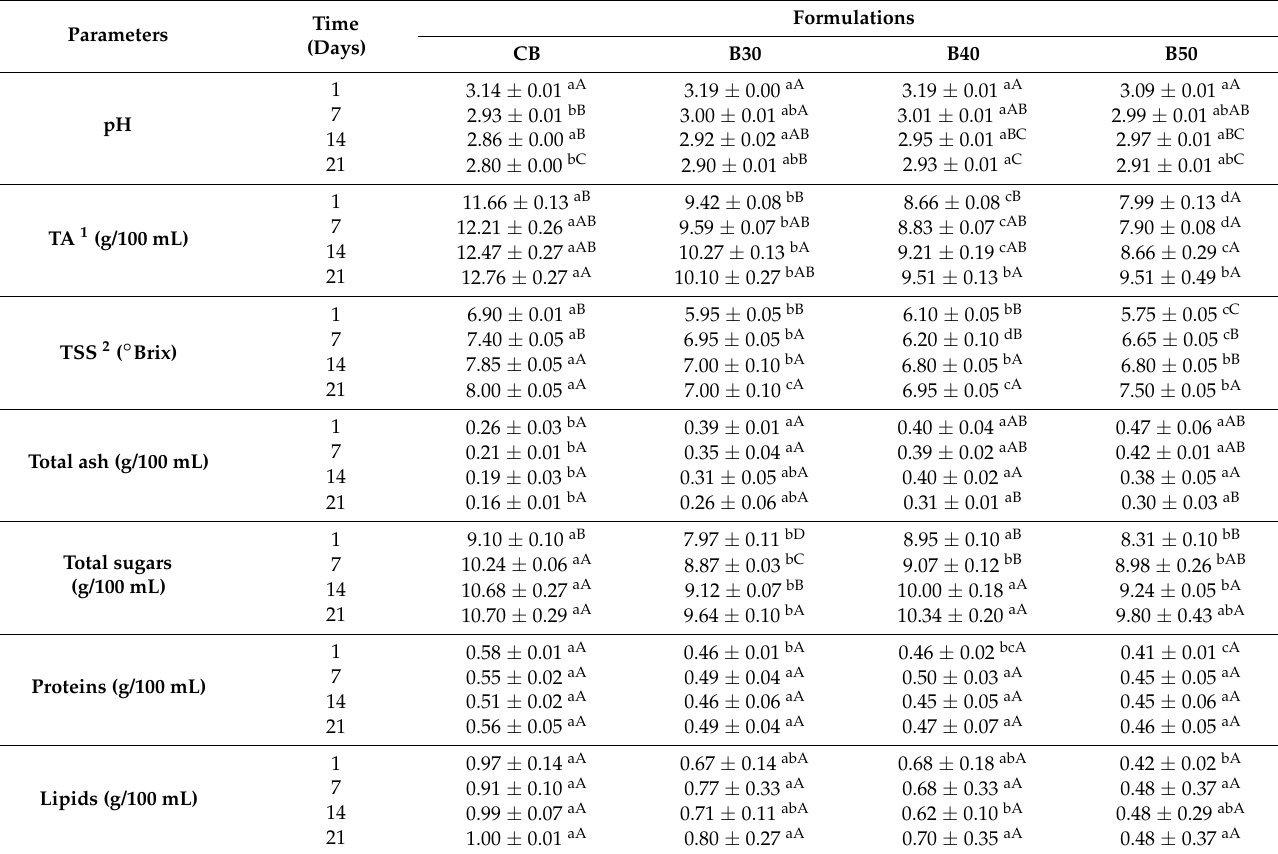
Table 2. Physical and physicochemical parameters of formulated beverages during 21 days of refrigeration storage (4 ◦ C).